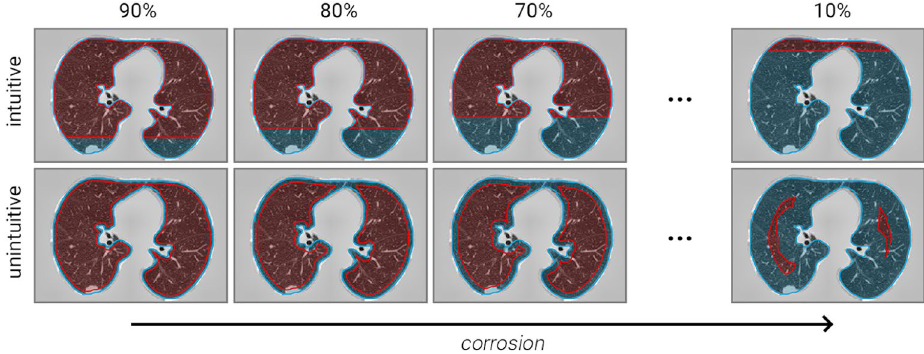
Figure 2. Synthetically crafted lung CT slices. The same starting slice was predelineated differently to simulate real involvement rates (18 slices and 9 involvement rates in total). Samples shown on the bottom row (unintuitive) should be more susceptible to overestimation, according to area perception theory.